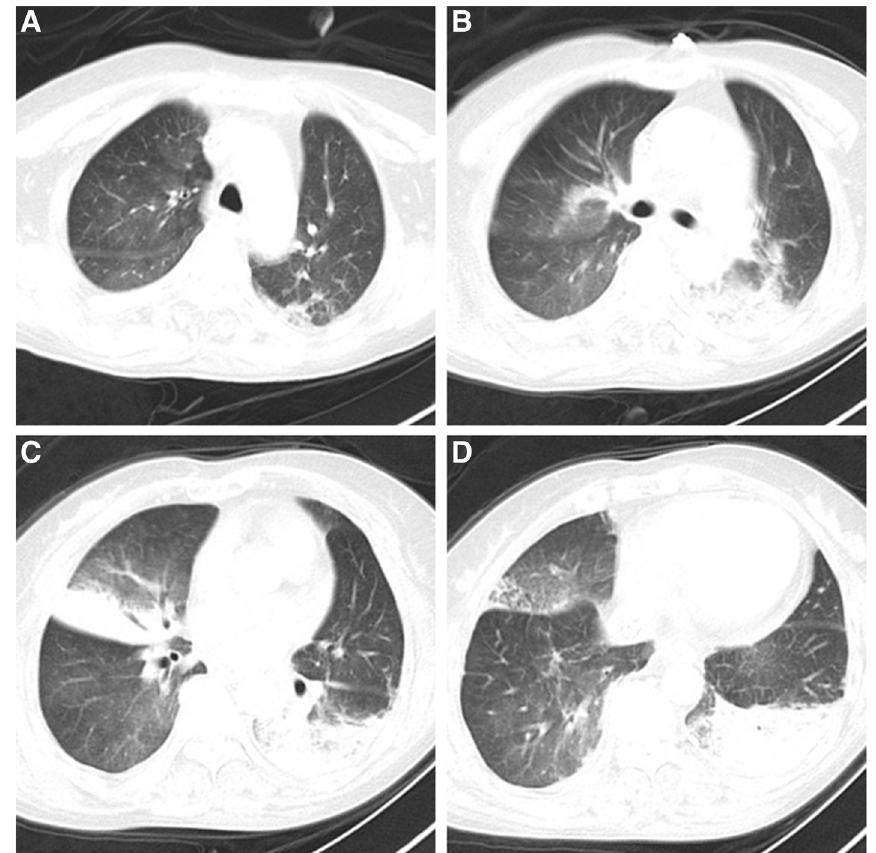
Fig. 5 Chest CT scan images (lung window) showed attenuated pulmonary consolidation and atelectasis before the withdrawal of